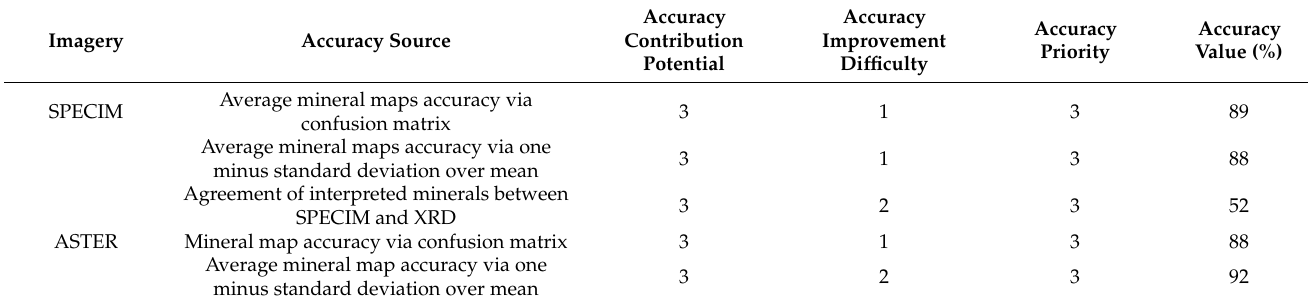
Table 1. Accuracy budget for the ASTER mineral map (accuracy contribution potential: 1 = low, 2 = medium, and 3 = high; accuracy control difficulty: 1 = very easy to 5 = very difficult; accuracy priority: 1 = low, 2 = medium, and 3 =